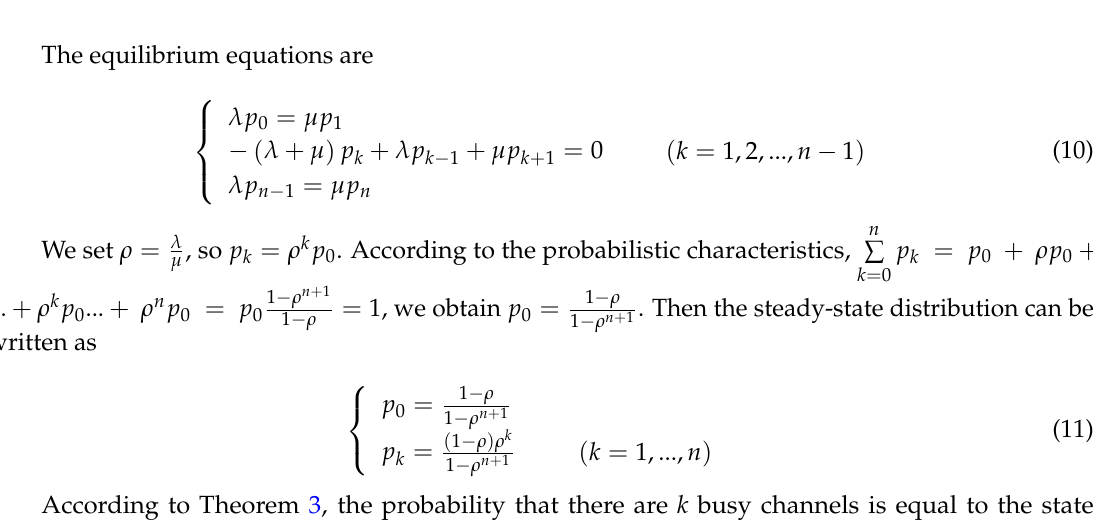
Figure 5. State transition diagram for enhanced channel hopping mechanism in Service-dependent coexisting